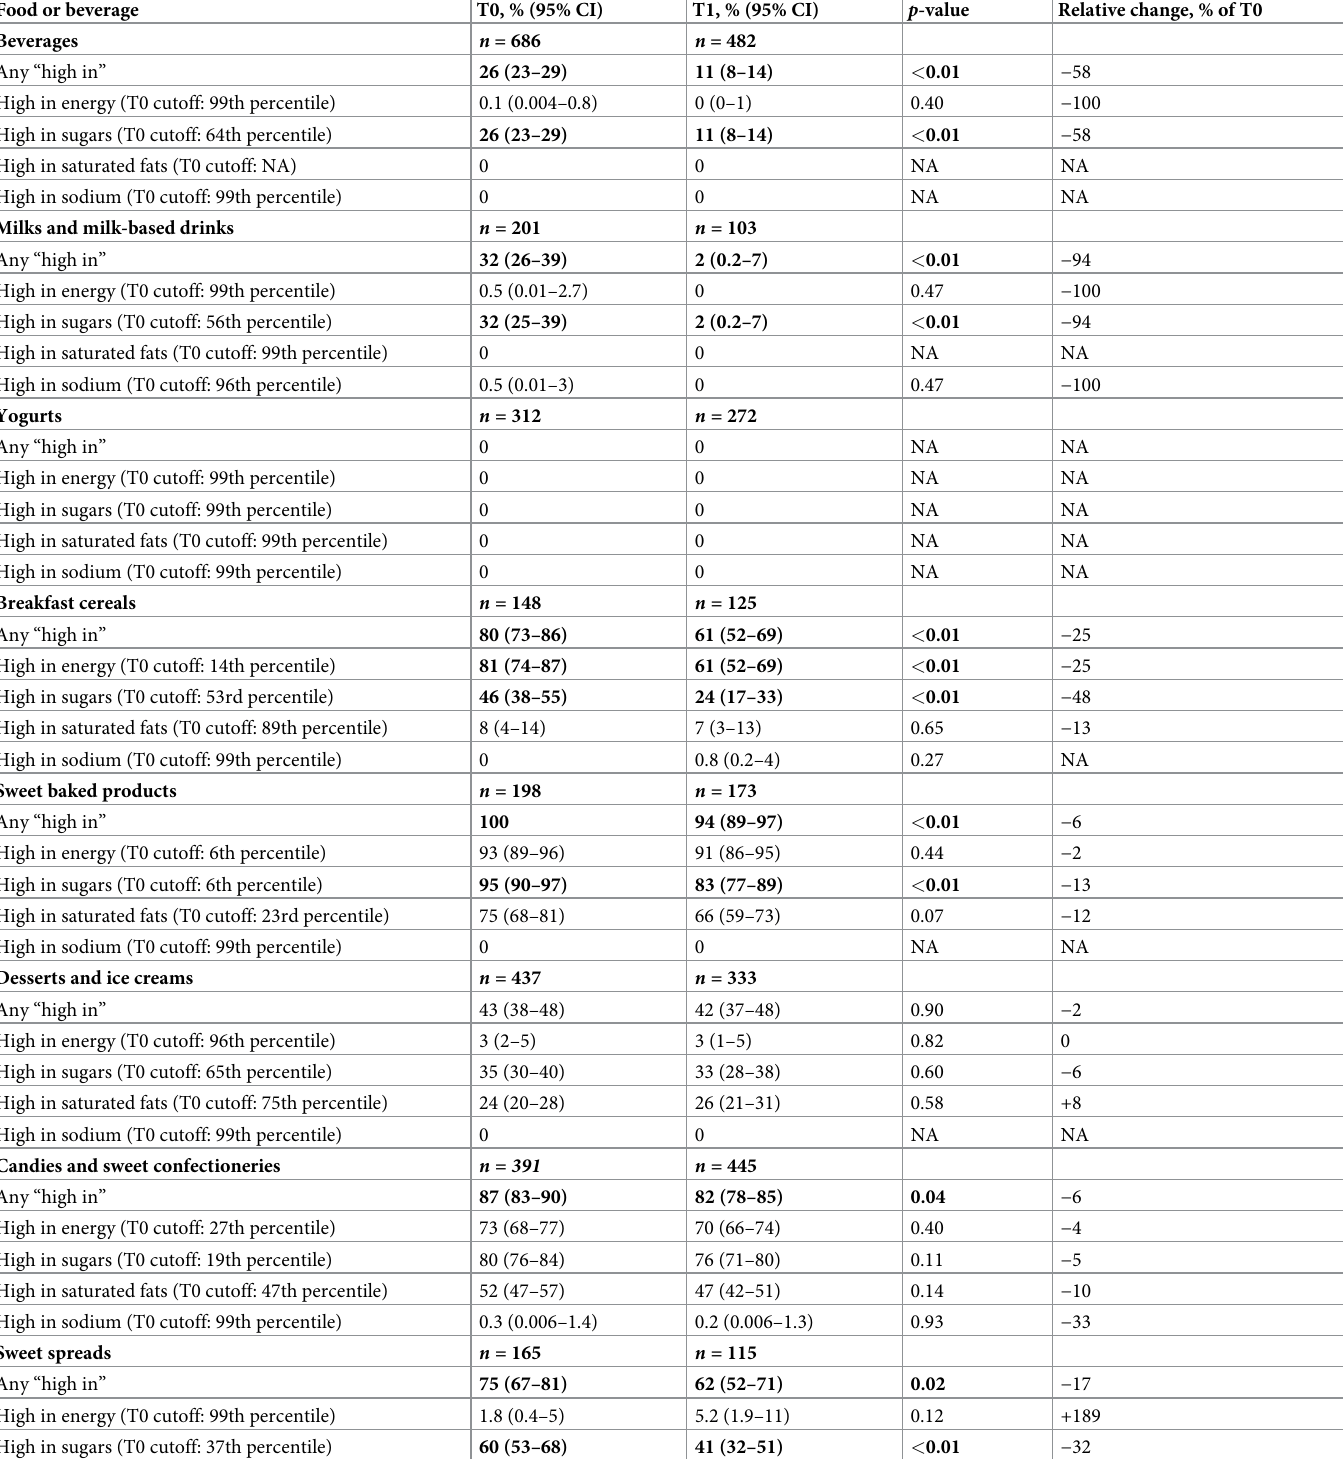
Table 1. Changes between T0 and T1 in the proportion of “high in” energy and nutrients of concern (or any “high in”) by food and beverage group, cross-sectional analysis. Food or